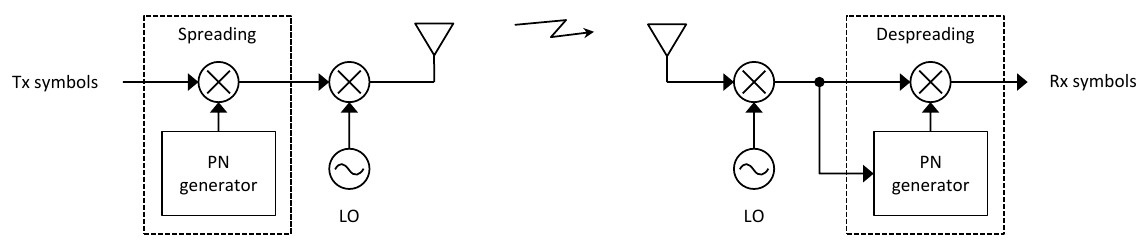
Figure 5. Simplified block diagram of a direct-sequence spread spectrum (DSSS) transceiver.